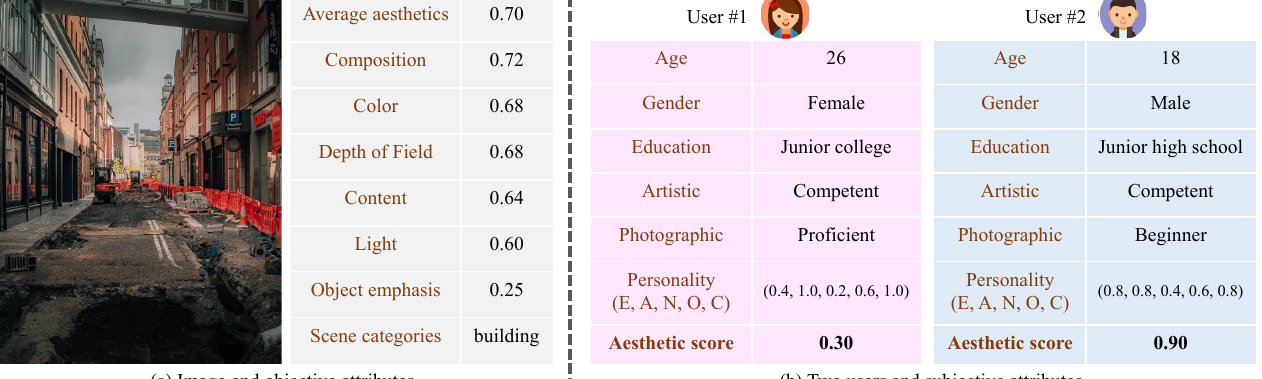
Figure 1. An image and two different users who rated it from the Personalized image Aesthetics database with Rich Attributes (PAPA) [10]. To their right, some objective attributes of the image and several subjective attributes of the users are shown. These numerical attributes and aesthetic scores are normalized between 0 and 1, and higher values indicate stronger attributes and aesthetics. The personality of users here is measured by the Big-Five traits (extroversion (E), agreeableness (A), neuroticism (N), openness (O), and conscientiousness (C))